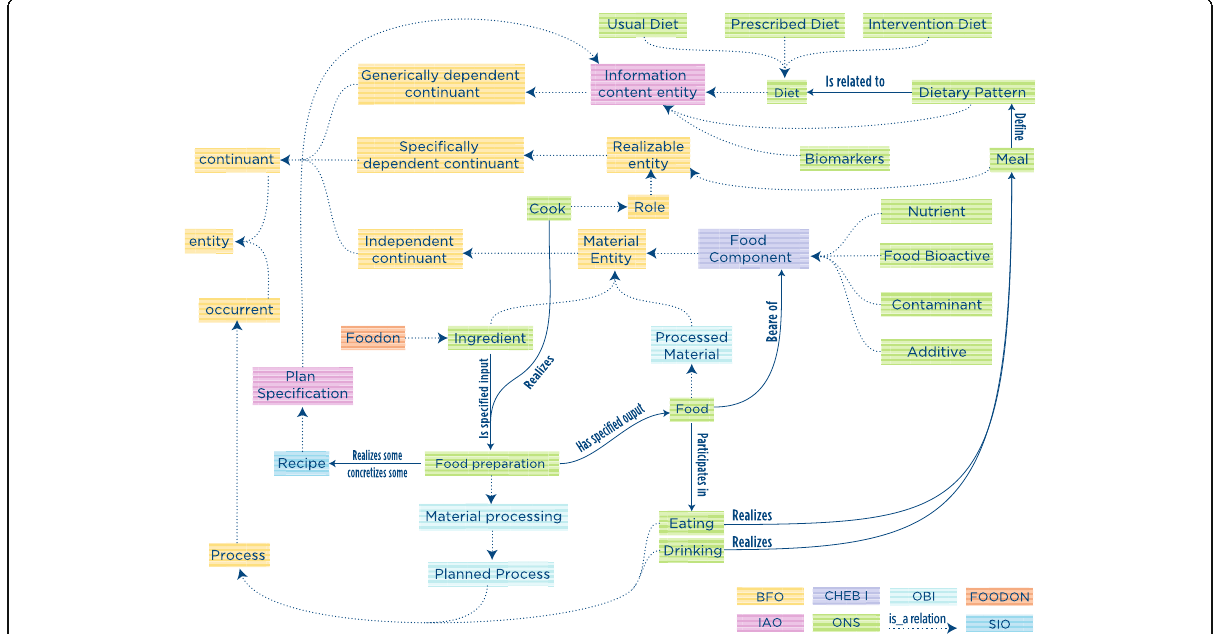
Fig. 1 Upper and mid-level hierarchical structure of the ONS showing how relevant nutritional concepts have been related to each other. Considering the large number of concepts and relations defined in the ONS, further detailed relations are not shown here. The terms in green boxes are ONS-specific terms, while terms in other color boxes are imported from existing ontologies (i.e., BFO, OBI, IAO, CHEBI, SIO, FOODON). Dotted arrows represent “ is_a ” semantic relations, while solid arrows represent other types of semantic